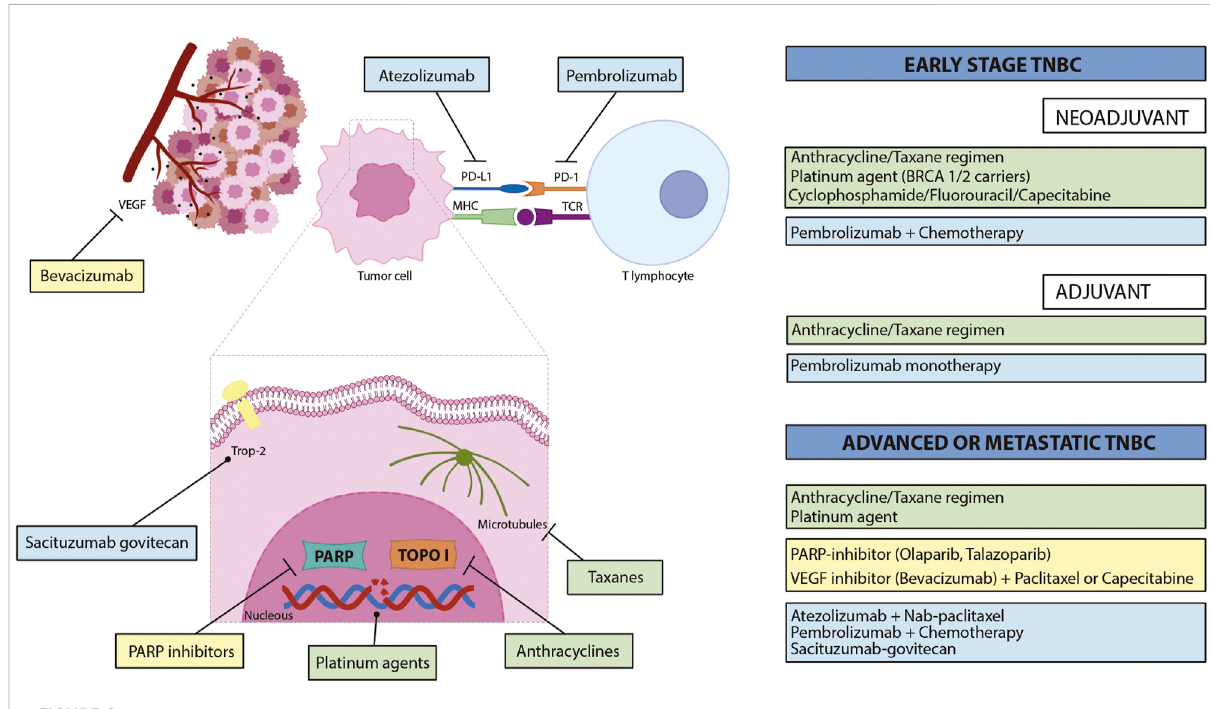
FIGURE 2 Currently approved pharmacological treatments of TNBC and their respective molecular targets. Green rectangles indicate chemotherapeutic regimens, yellow rectangles illustrate targeted therapies, and light blue rectangles refer to immunotherapies. PD-L1 — programmed death-ligand 1; PD-1 — programmed cell death protein 1; MHC — major histocompatibility complex: TCR — T-cell receptor; PARP — poly(ADP-ribose) polymerase; TOPO I — topoisomerase